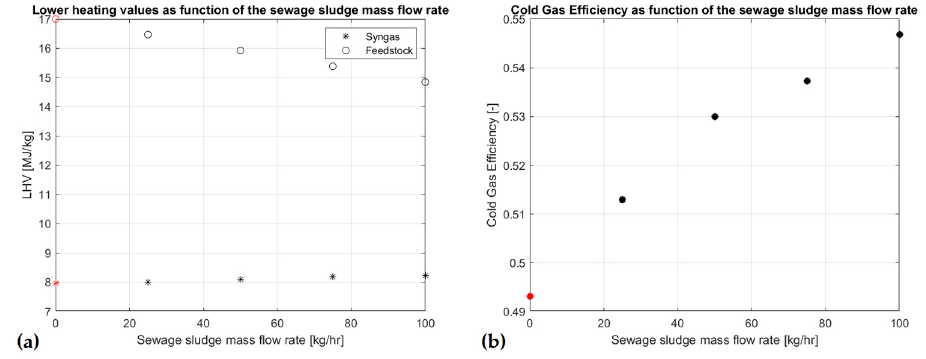
Figure 10. ( a ) Syngas and feedstock lower heating value (LHV) as a function of sewage fraction; ( b ) cold gas efficiency as a function of the sewage fraction.